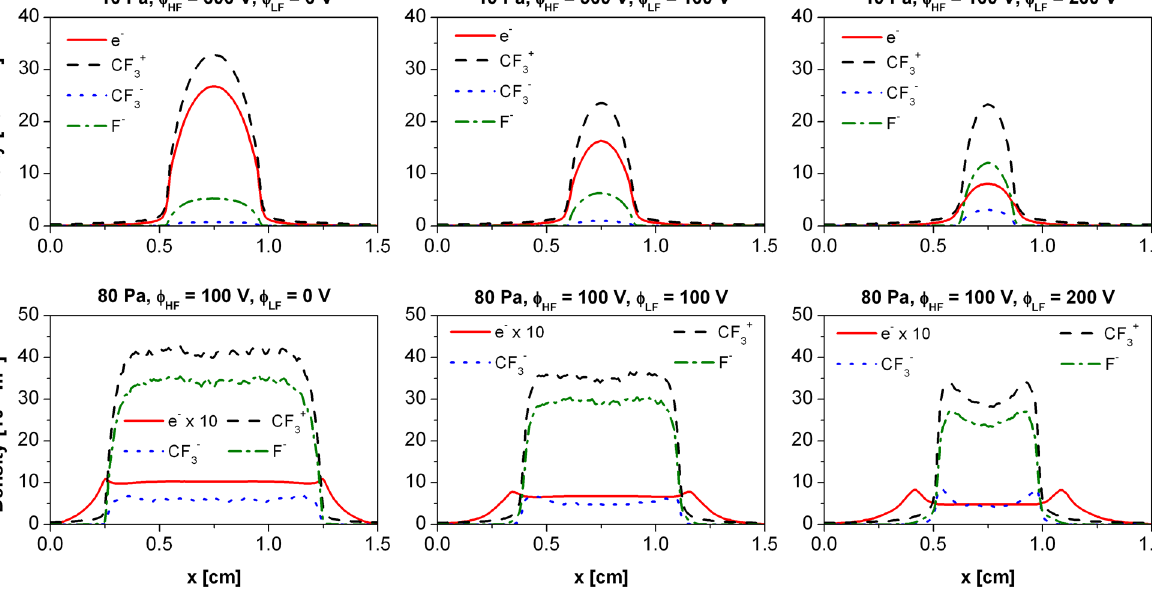
=0 V. Second column: LF